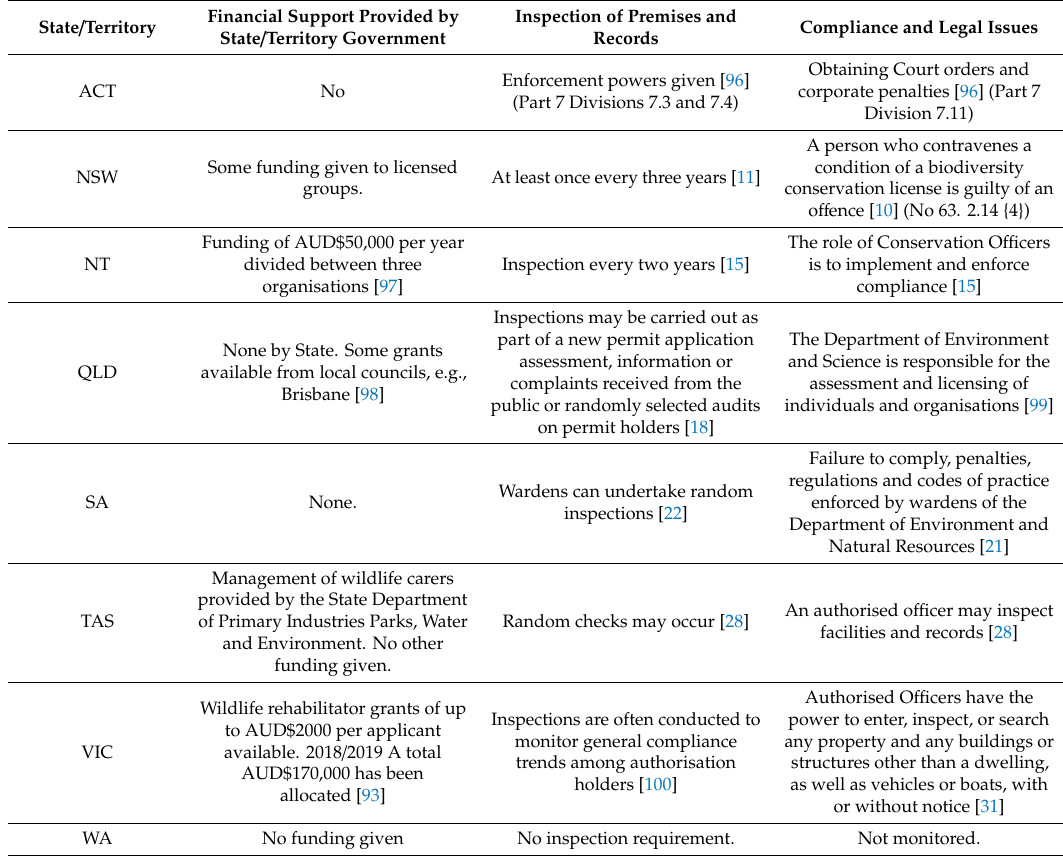
(Table 5). All states legislate to enable o ffi cials to require wildlife carers to submit to inspection of their records, premises, or facilities they provide for rescued rehabilitating animals (Table 5). Table 5. Funding and monitoring of wildlife carers and carer networks in